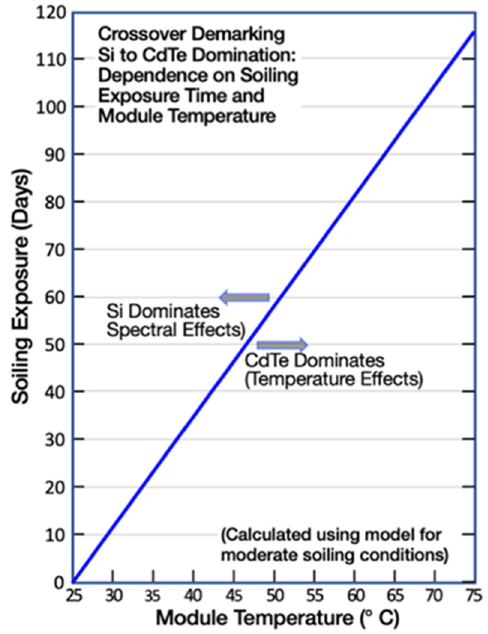
Figure 13. Crossover from Si to CdTe dominations as a function of soiling exposure time and module temperature. For example, analysis supported by experiments predicts that at a module operating temperature of 50 ◦ C, spectral effects of the soiling layer would only start to be effective for soiling exposure days more than ~58 days of exposure for Si over the CdTe